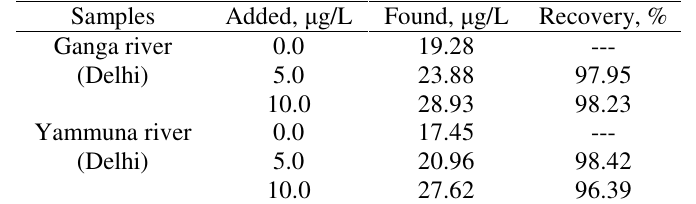
Table 3. Analytical recovery of Pb(II) added to natural water samples.